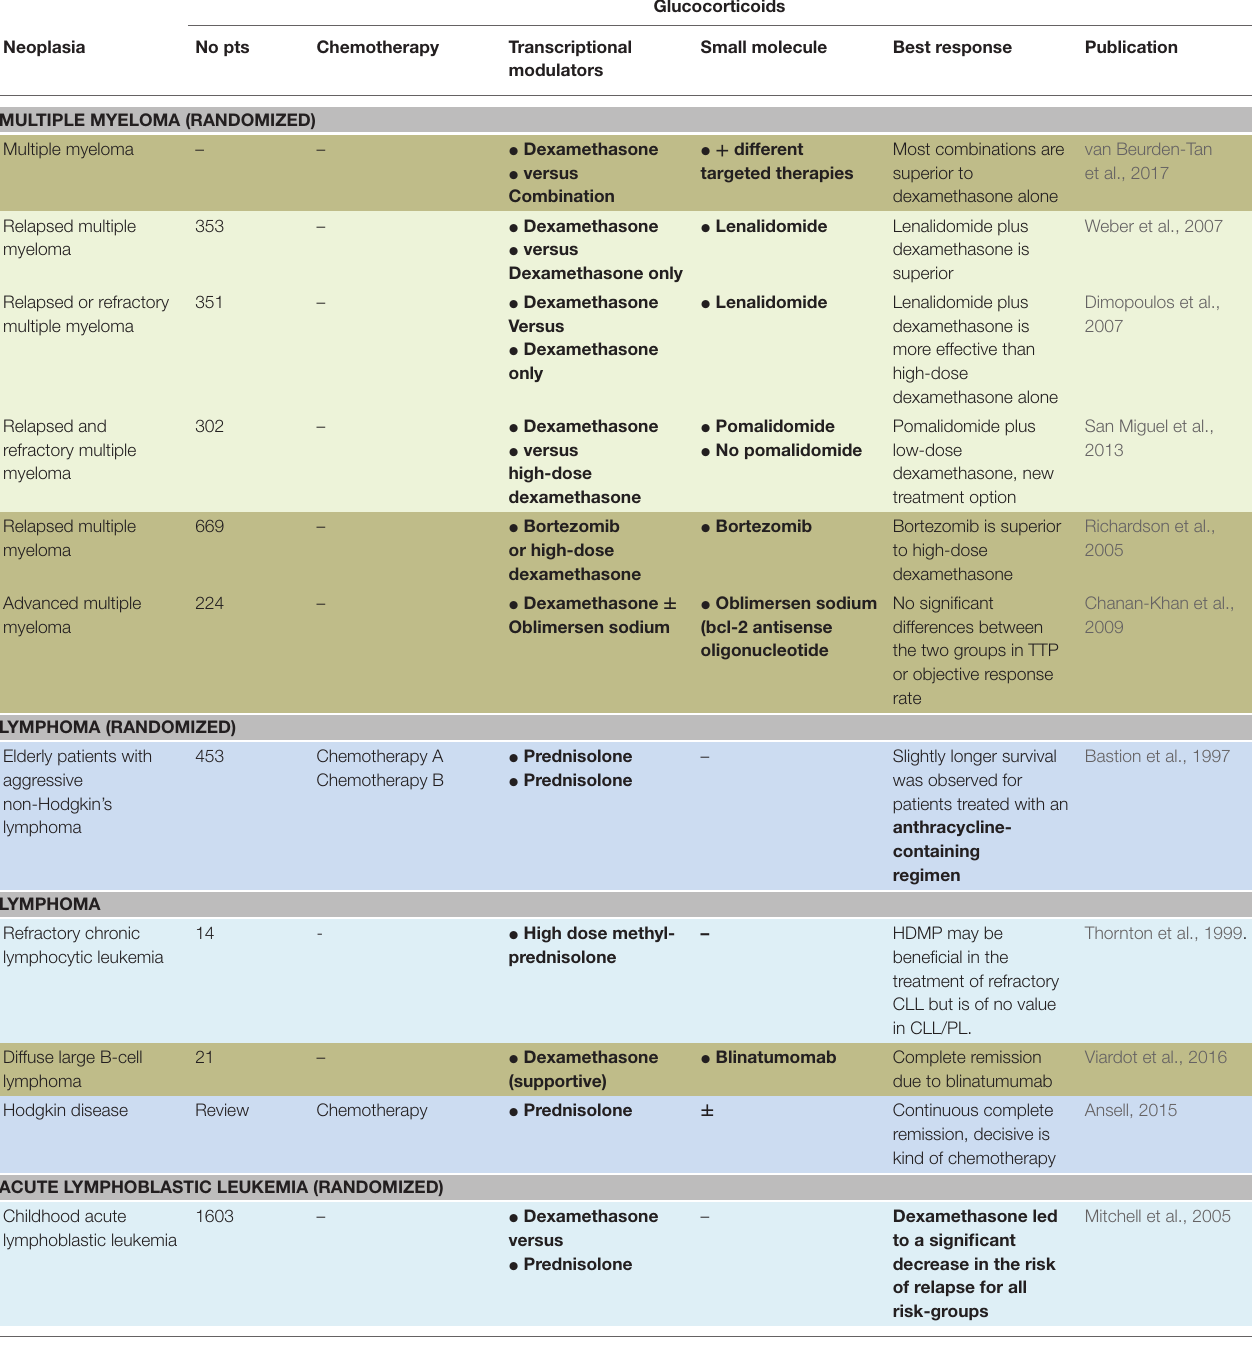
TABLE II | Communicative reprogramming of tumor